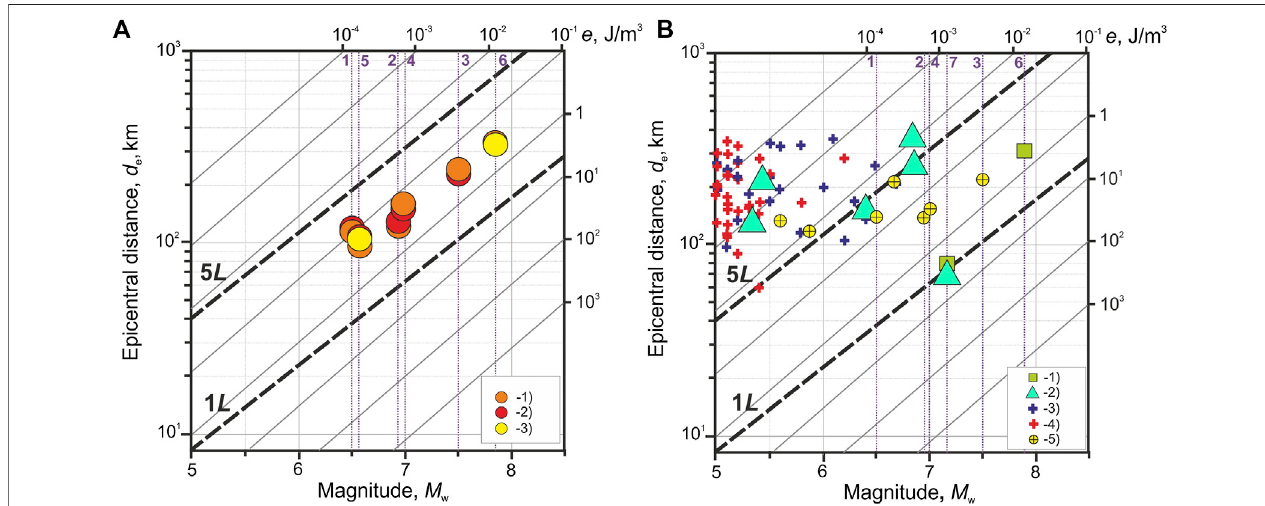
FIGURE 2 | Distribution of earthquake hydrogeological precursors in the observation wells as function of the parameters of the subsequent earthquakes: magnitude M w , epicentral distance d e , and speci fi cdensity of seismic energy e : (A) hydrogeological precursors in chemical composition ofwater in fl owing wells (1) GK- 1, (2) M-1, (3) G-1 ( Supplementary Materials Table S2 ); (B) hydrogeological precursors in water-level changes in wells (1) YuZ-5, (2) – (5) E-1: (2) PS1, determined in real time with the issuance of a conclusion on a possible earthquake for KB REC; (3) 1996 – 2012 earthquakes with M ≥ 5.0, d e ≤ 350 km preceded by retrospectively identi fi ed PS1 ( Supplementary Materials Table S3 ); (4) 1996 – 2012 earthquakes with M ≥ 5.0, d e ≤ 350 km not preceded by PS1, and (5) water-level decreasesatanincreasedrateprecededthe1987 – 1996earthquakes(Table3inKopylova,2001).Thinverticaldottedlinesonthemagnitudescaleindicateearthquakes precededbyhydrogeologicalprecursorsintwotofourwells,theearthquakenumberscorrespondtothenumbersin SupplementaryMaterialsTableS2 .Thelines1 L , 5 L show one and fi ve maximal linear sizes of the